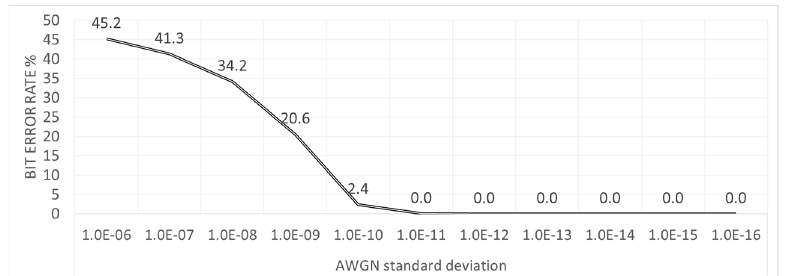
Figure 10. BER percentage vs. AWGN standard deviation.